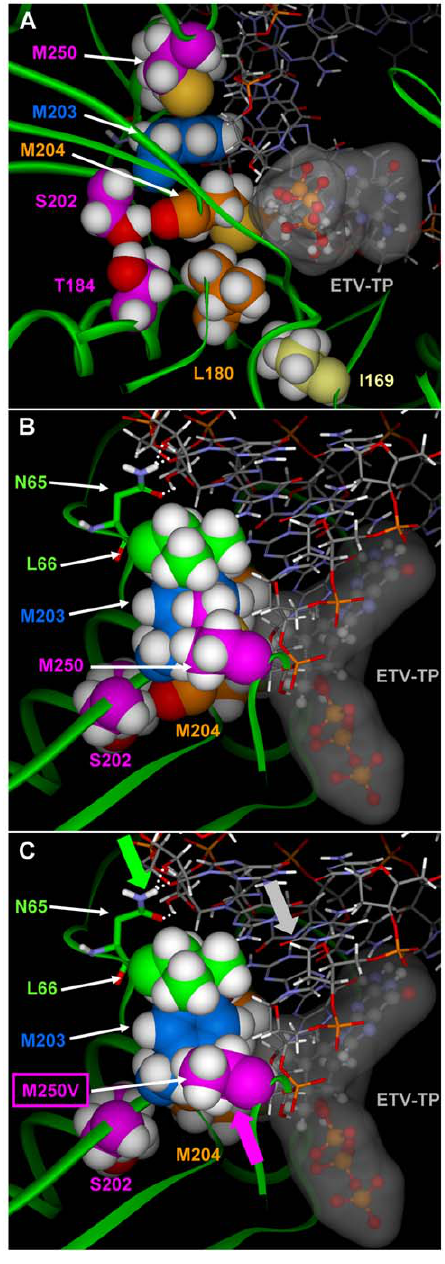
Figure 4. Position of residue M250 in the HBV RT/DNA molecular model. A) The relative location of the M250, Y203, M204V, and other resistance residues are shown with primer-template DNA and ETV-TP in the dNTP binding site. The proximity of the M250 residue to both primer DNA and the Y203 residue are shown, indicating possible mechanisms for effects of M250 substitutions on the dNTP binding site, as well as the influence different side chains could have on primer positioning. B) M250 is packed against L66 and N65 forms hydrogen bonds (white dotted lines) to the hydroxyl groups on the backbone of the RNA template strand. C) The smaller side chain of the M250V no longer packs against L66. As indicated by the arrows (protein:green; DNA:gray; M250V:purple), the resulting conformational change in the protein to close the resultant hole repositions the RNA/ DNA slightly over the NTP binding site. The slight modification to the NTP site enhances LVD binding while decreasing the binding affinity of ETV.